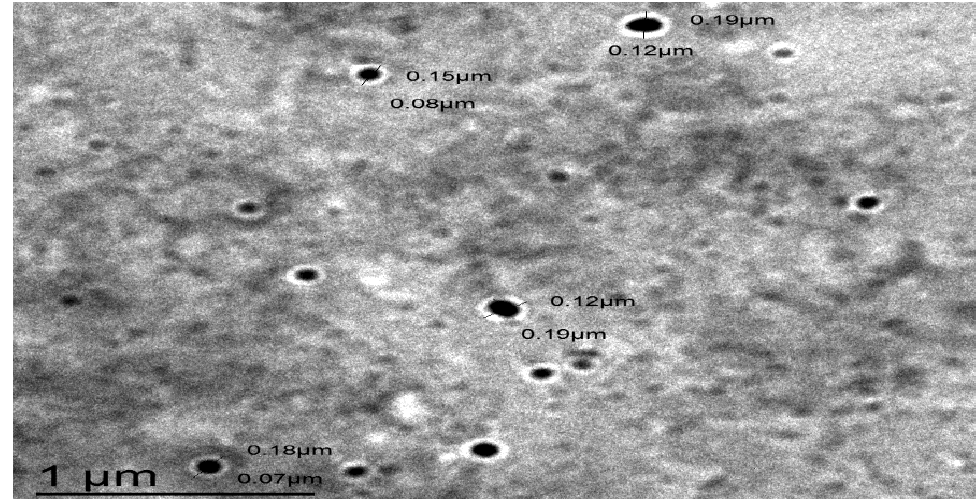
Figure 9. A transmission electron microscope (TEM) image of SGN–TC nanoparticles (F3).